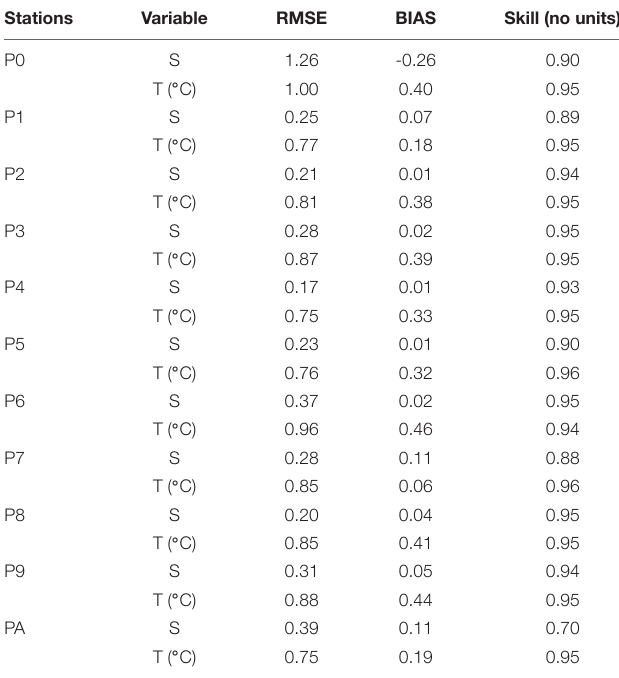
TABLE 2 | Model-measured data comparison calculations for salinity (S) and temperature (T; ◦ C) along all the water column.